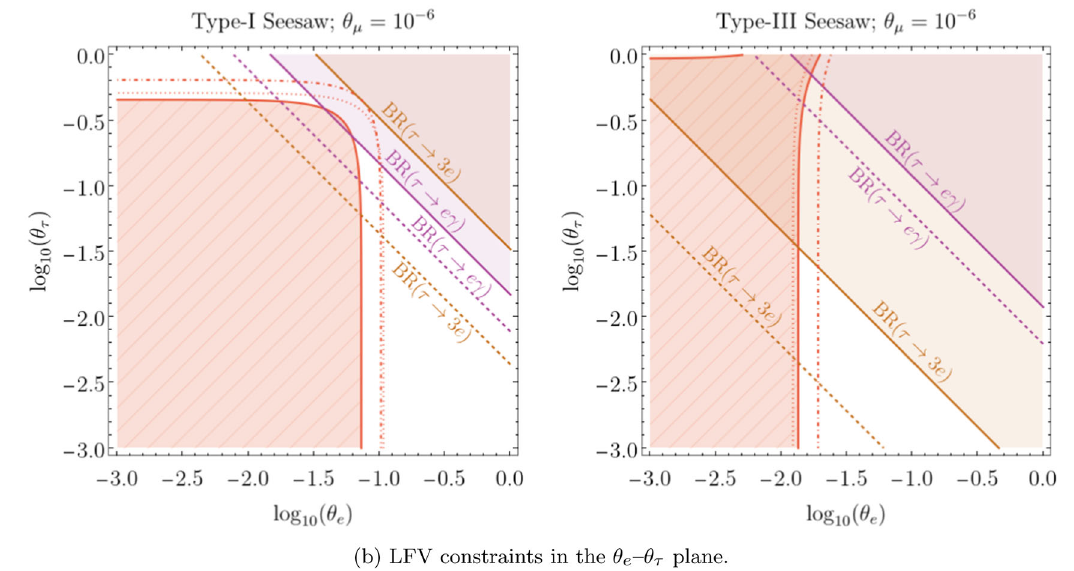
√ s = 240GeV and 365GeV, respectively. We do not depict the at bounds from tau-flavoured processes in the θ e – θ μ plots, and vice versa. If included, they would appear as vertical lines with positioning highly √ s = 240GeV. The dependent on the choice of the third mixing angle, which limits their